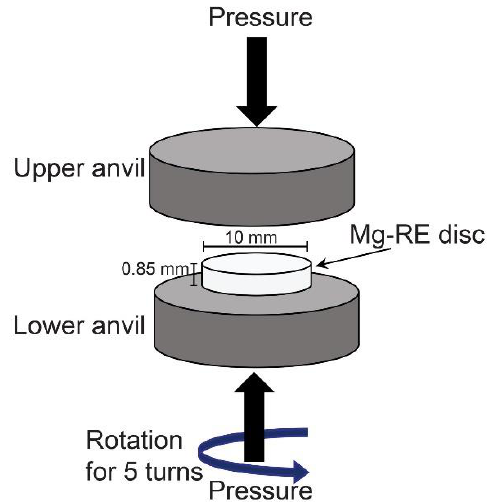
Figure 1. Schematic illustration showing the HPT processing.